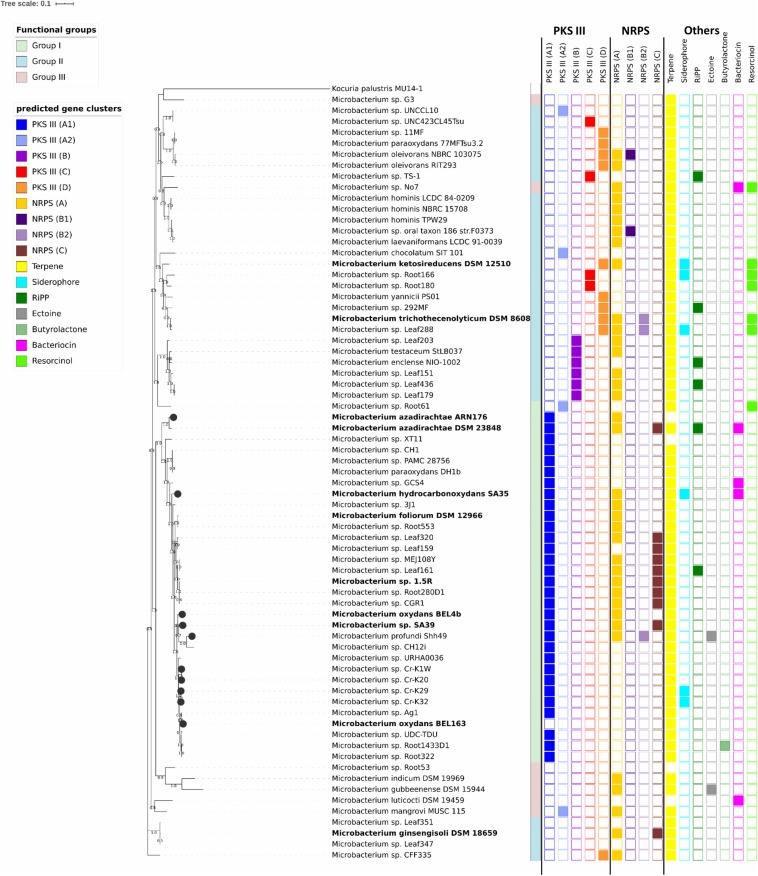
Maximum likelihood phylogenetic tree based on 38 concatenated unique marker genes identified using Phylosift (Darling et al., 2014). Kocuria palustris MU14/1 (CP012507) was used as outgroup. Bootstrap values > 50% are shown at branch points. Strains belonging to phylogenetic groups I, II and III are highlighted in green, blue, and red, respectively. Isolates in bold were tested in this study. Isolates marked with a black circle were isolated from heavy metal contaminated sites. The first column on the right side of the tree shows the different types of PKS gene clusters; whereas the second and third columns show the different types of NRPS gene clusters. The bars indicate the other predicted secondary metabolite gene clusters identified with antiSMASH 5.0.